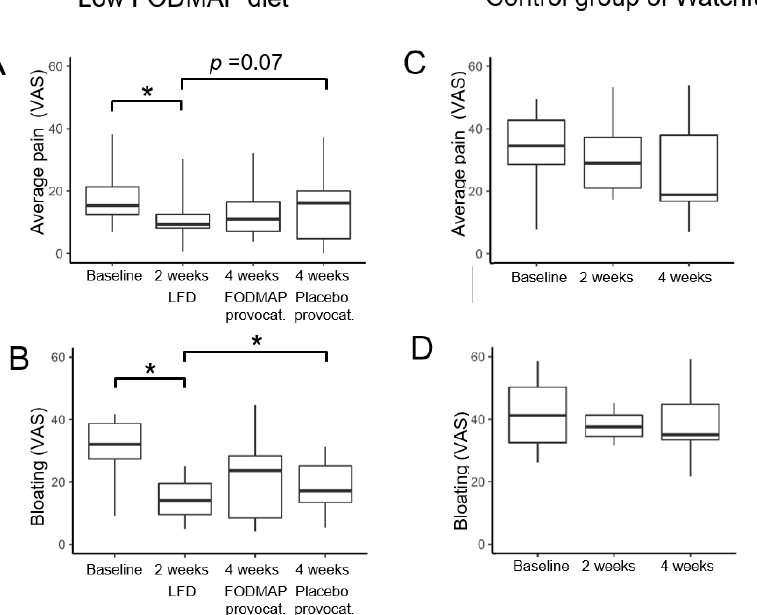
Figure 4. The results of the symptom diaries showed that watchful waiting in the control group resulted in a 50% pain reduction ( A ) and bloating reduction trend ( B ). In diet groups, two weeks on the open-label low-FODMAP-diet resulted in significant decreases in pain and bloating scores ( C , D ). However, after the subsequent two weeks provocations, pain and bloating scores returned to baseline levels regardless of the provocation placebo ( p < 0.05, nocebo effect) or FODMAPs ( C , D ). * p < 0.05